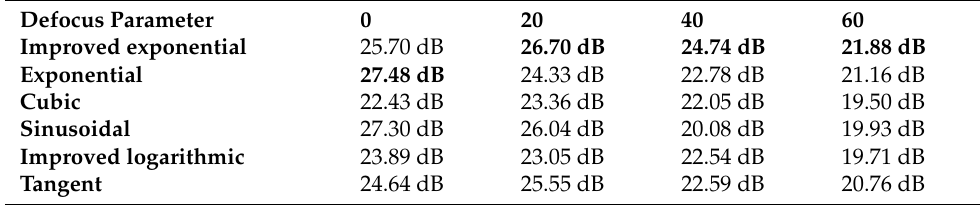
Table 2. RIQ factors of six phase